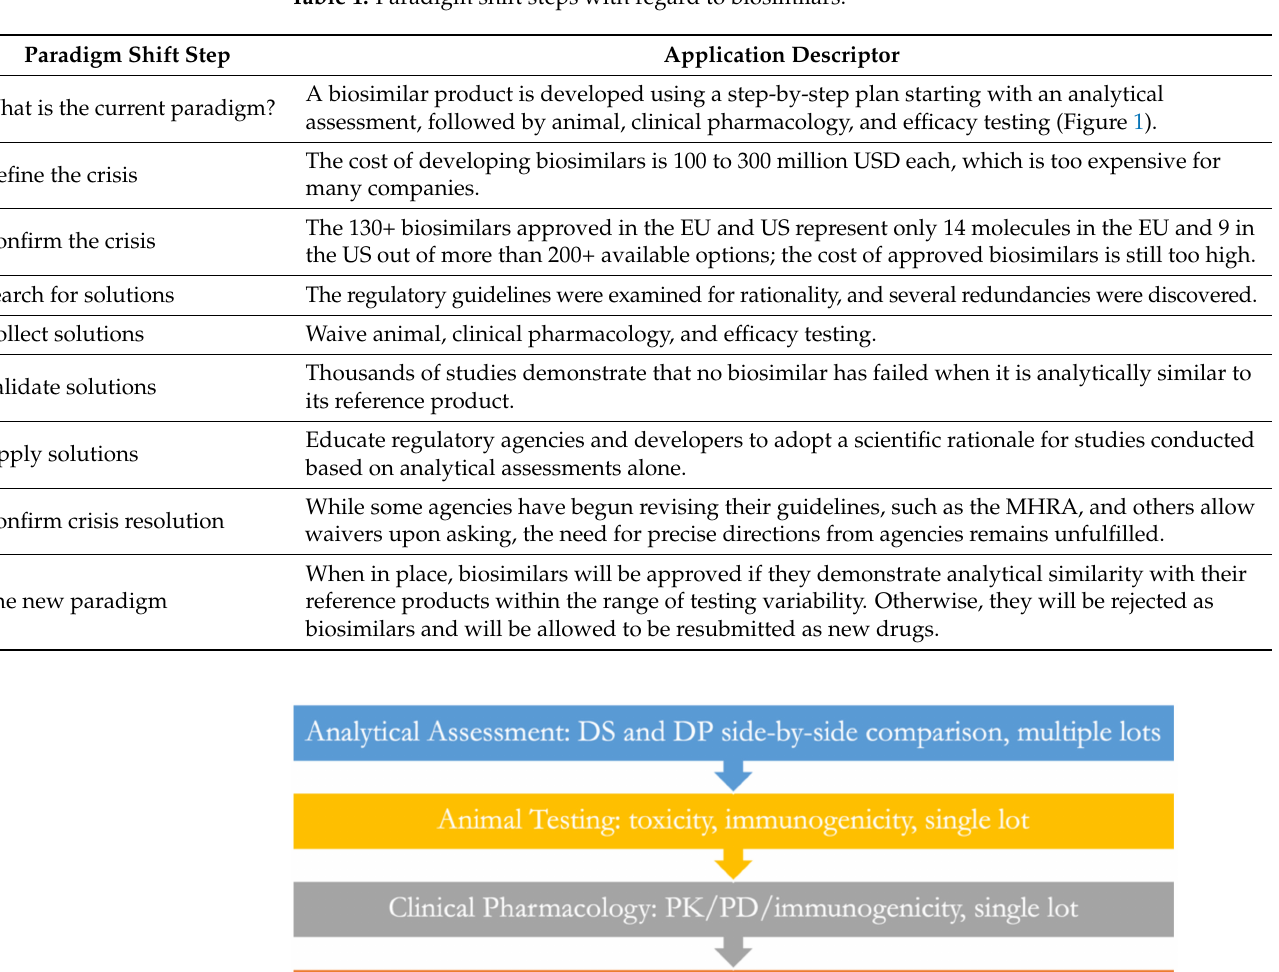
Table 1. Paradigm shift steps with regard to biosimilars.